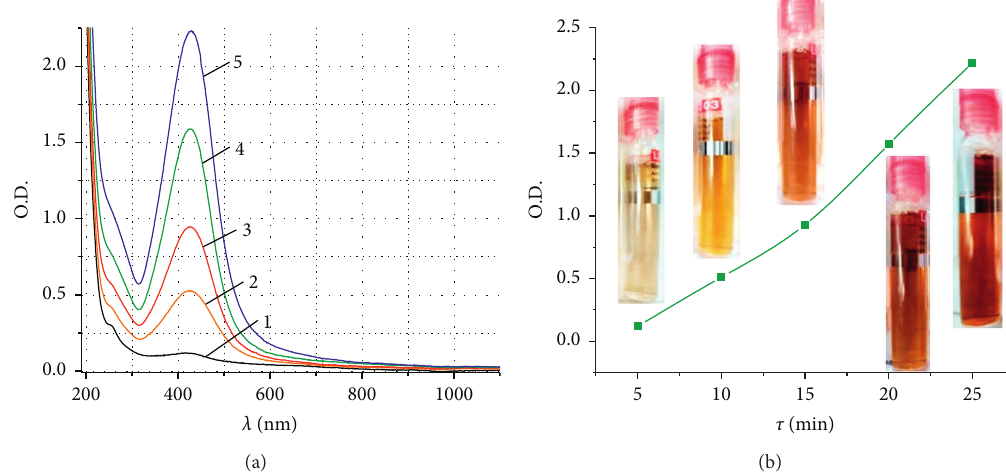
Figure 3: Spectral dependences of optical absorption of AgNPs obtained by sonoelectrochemical synthesis (a) at different process durations (min): 1–5; 2–10; 3–15; 4–20; and 5–25 and (b) change of O.D. maximum and color over